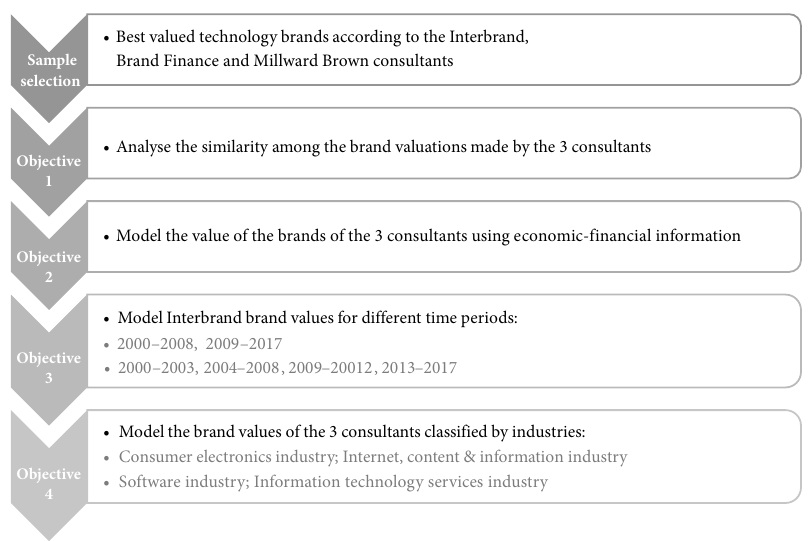
Figure 1. The research